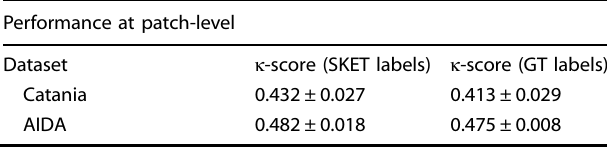
Table 4. Results for the performance of the CNN on the fi ve classes patch-level classi fi cation task. The performance is evaluated with Cohen ’ s κ -score, reporting the average and the standard deviation of the models involved in the k-fold cross-validation. The performance is reported for the CNNs trained using the automatically generated weak labels (SKET labels) and the manually created weak labels (GT